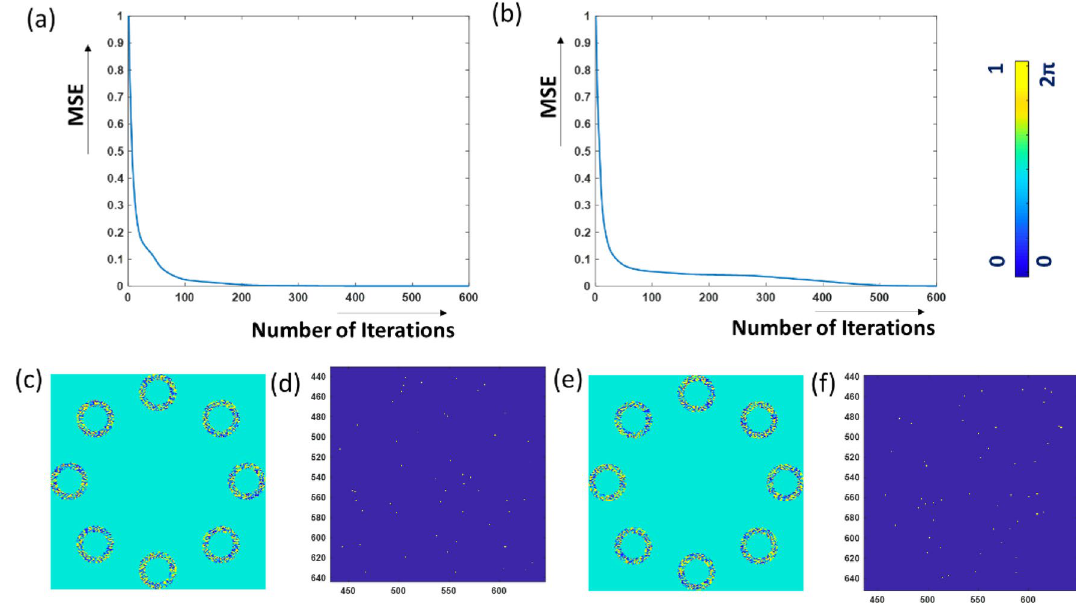
Figure 5. ( a , b ) MSE plots obtained during the synthesis of two independent CPMs; The obtained ( c ) CPM 1 and ( e ) CPM 2 by GSA; the desired ( d ) sparse intensity pattern of CPM 1 and ( f ) the dotted intensity pattern of CPM 2